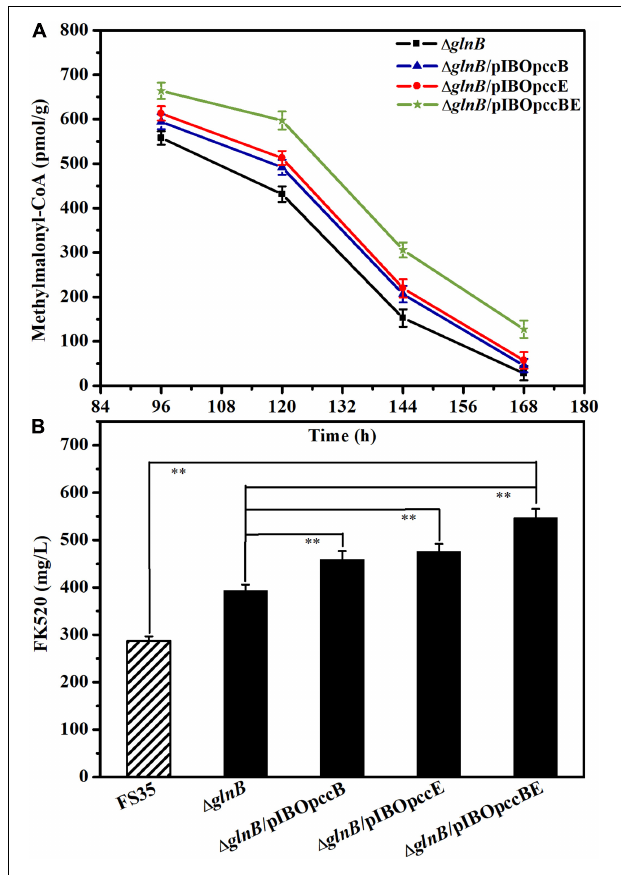
FIGURE 6 | Influence of pccB and pccE overexpression on the methylmalonyl-CoA concentration and FK520 yield. (A) Changes of the methylmalonyl-CoA content caused by the overexpression of pccB and pccE alone or in combination. The concentration of methylmalonyl-CoA in the deletion strain (cid:49) glnB was used as a reference for comparison. The data represent the mean values of three independent technical replicates, and the error bars represent the standard deviations. (B) Changes of the FK520 yield caused by the overexpression of pccB and pccE alone or in combination. The FK520 yield of the deletion strain (cid:49) glnB and parent strain FS35 were used as references for comparison. The data represent the mean values of five independent technical replicates, and the error bars represent the standard deviations. Asterisks indicate significant differences between the parent strain FS35 and the engineering strains. P -values were calculated using two-tailed Student’s t -test. Double asterisk indicates P < 0.01. The (cid:49) glnB represents the glnB deletion strain based on the parent strain FS35. The (cid:49) glnB /pIBOpccB represents the pccB overexpression strain based on the (cid:49) glnB strain. The (cid:49) glnB /pIBOpccE represents the pccE overexpression strain based on the (cid:49) glnB strain. The (cid:49) glnB /pIBOpccBE represents the pccB and pccE co-overexpression strain based on the (cid:49) glnB strain.